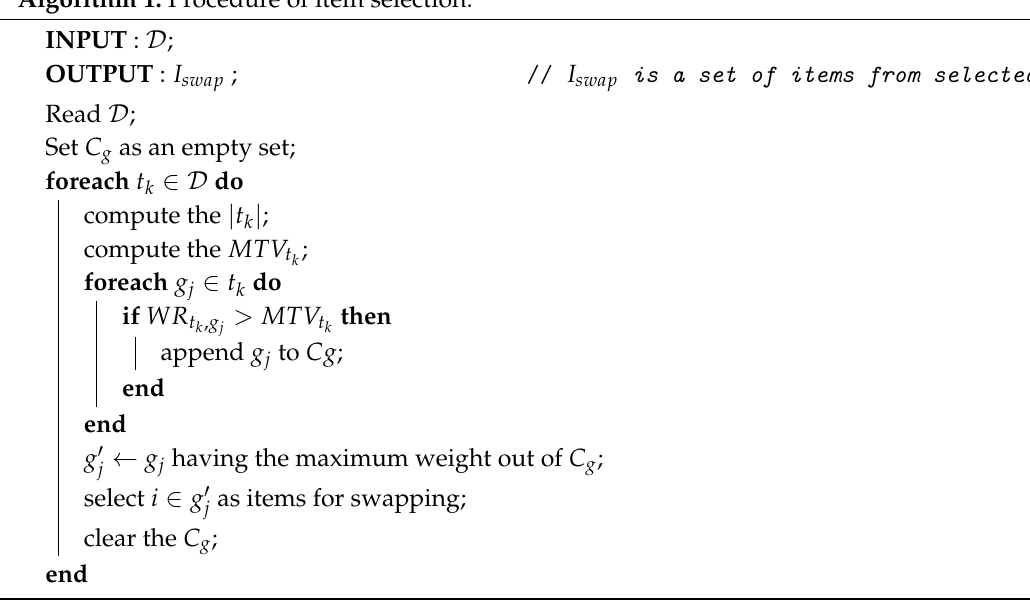
Algorithm 1: Procedure of item